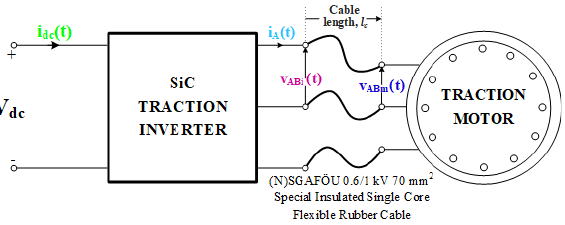
Figure 24. Experimental setup to test the effects of cable length on the system performance.